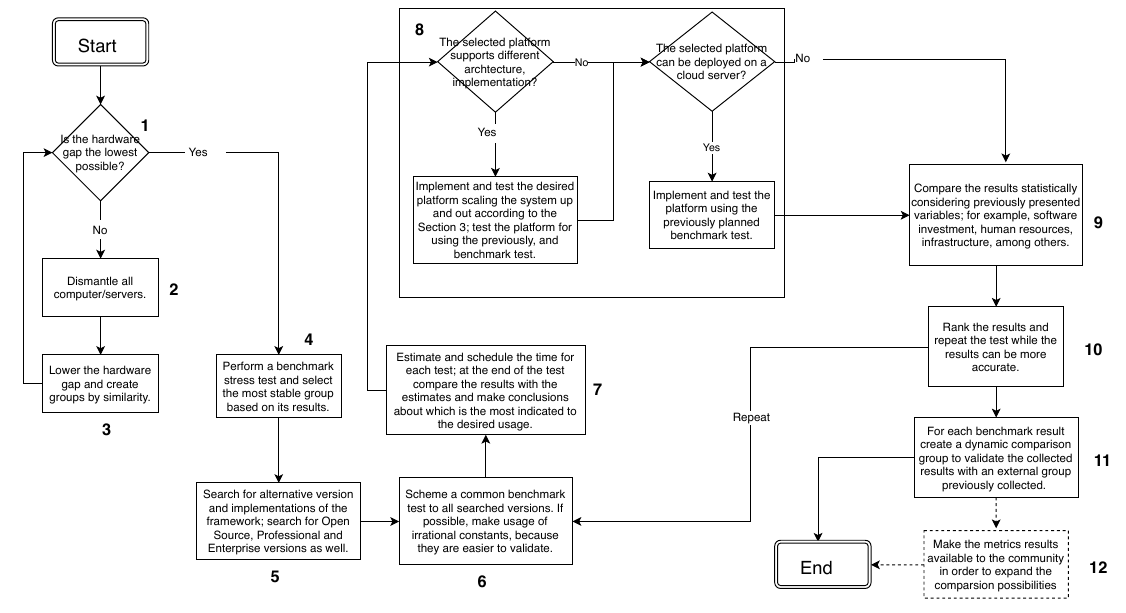
Figure 3. Methodology as a